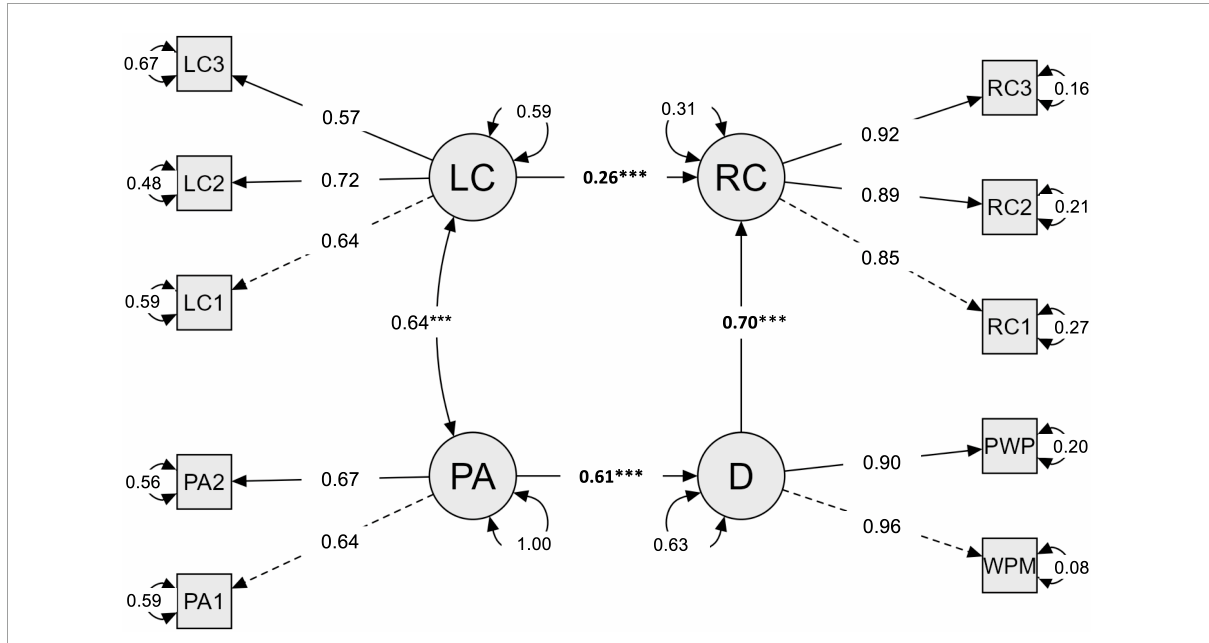
FIGURE4 Standardized parameter estimates for the structural equation models with fourth-grade children. *** p < 0.001. D, Word recognition; RC, Reading comprehension; PA, Phonological awareness; LC, Language comprehension; WPM, Words per minute (correct); PWP, Pseudowords per minute (correct).